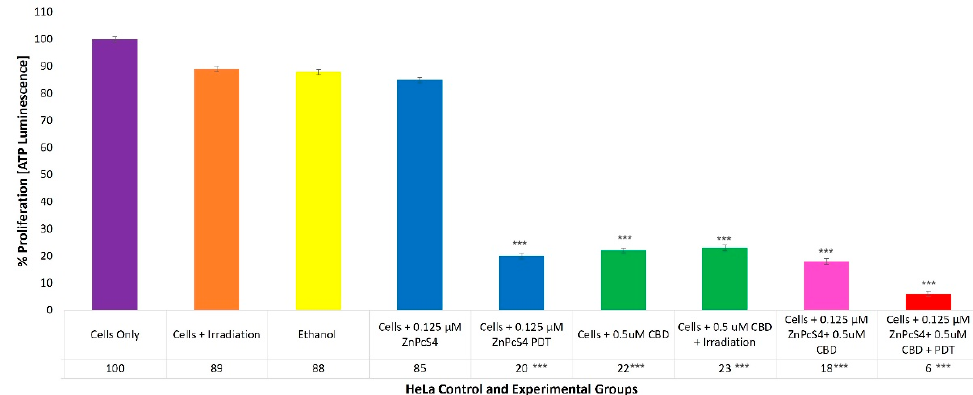
Figure 7. Percentage of cell proliferation among various HeLa control and experimental groups, within ZnPcS 4 PS and CBD post-irradiation combinative assays ( p < within ZnPcS 4 PS and CBD post-irradiation combinative assays ( p < 0.001***). The cells-only positive control, which received no forms of treatment, noted a 100% (±SEM 1.07) viable population of cells capable of cellular proliferation, and was thus con- sidered an acceptable standard for result comparisons and statistical data interpretations.